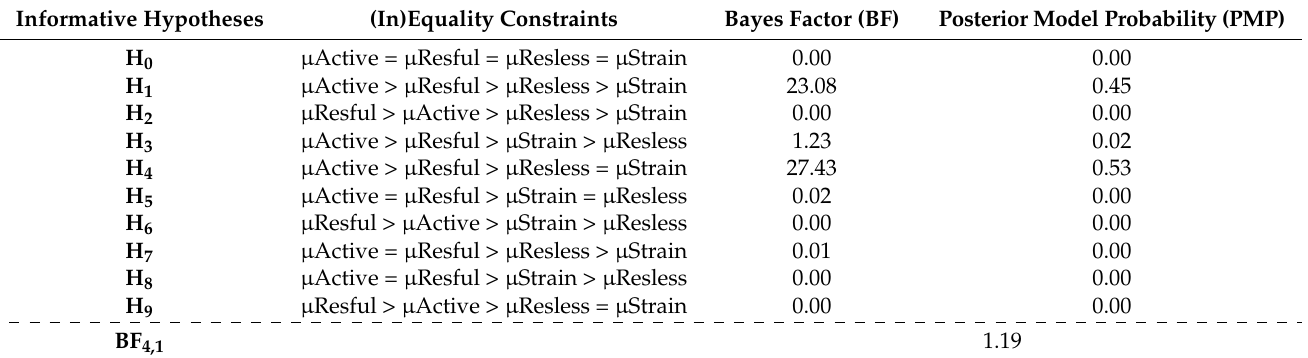
Table 5. Bayesian evaluation of the study informative hypotheses (dependent variable = job satisfaction). Informative Hypotheses